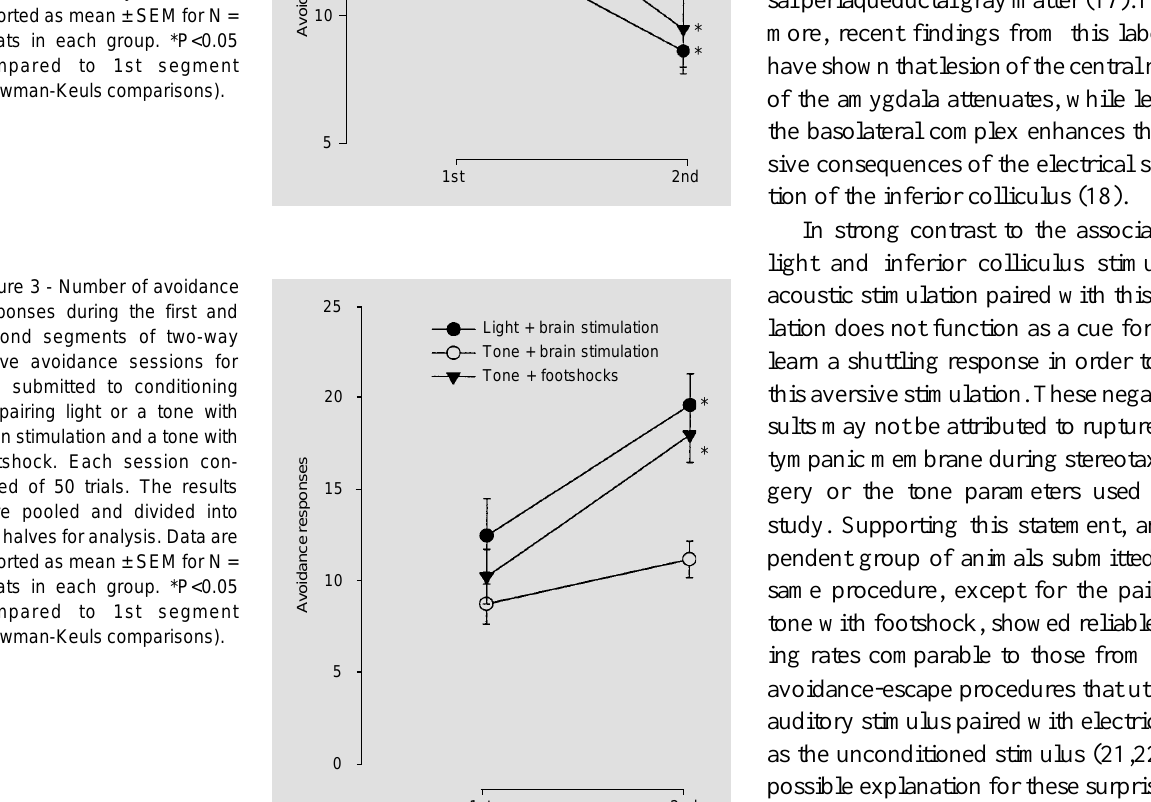
Figure 2 - Latencies of avoidance responses during the first and second segments of two-way active avoidance sessions for rats submitted to conditioning by pairing light or a tone with brain stimulation and a tone with footshock. Each session con- sisted of 50 trials. The results were pooled and divided into two halves for analysis. Data are reported as mean ± SEM for N = 8 rats in each group. *P<0.05 compared to 1st segment (Newman-Keuls comparisons).